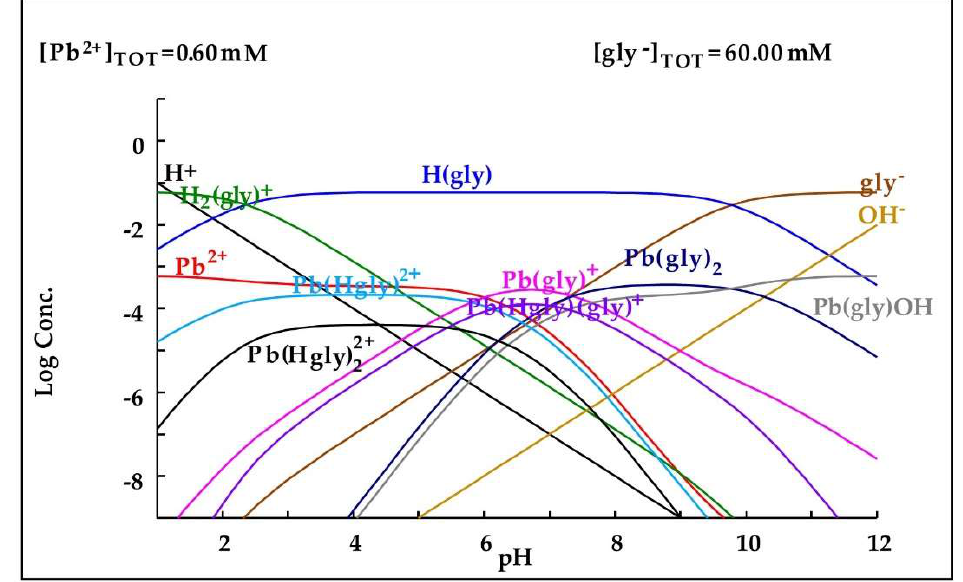
Figure 9. Diagram of distribution of species of the Pb 2+ -glycine − system based on the concentrations present in the leaching medium. Diagram made by the authors in Medusa software version 2010.